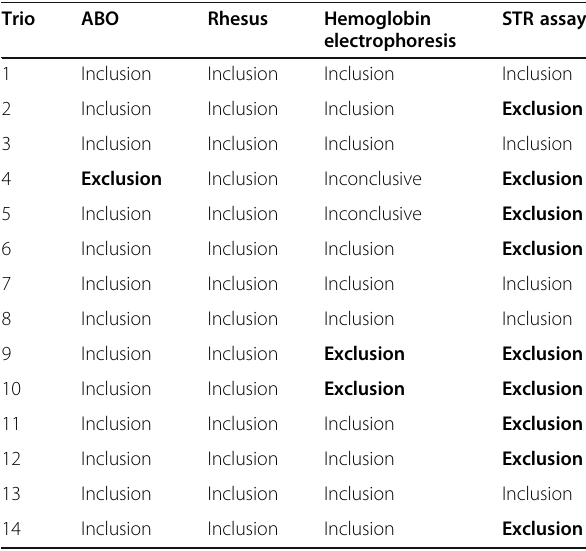
Table 5 Comparison of Inclusion and exclusion results by